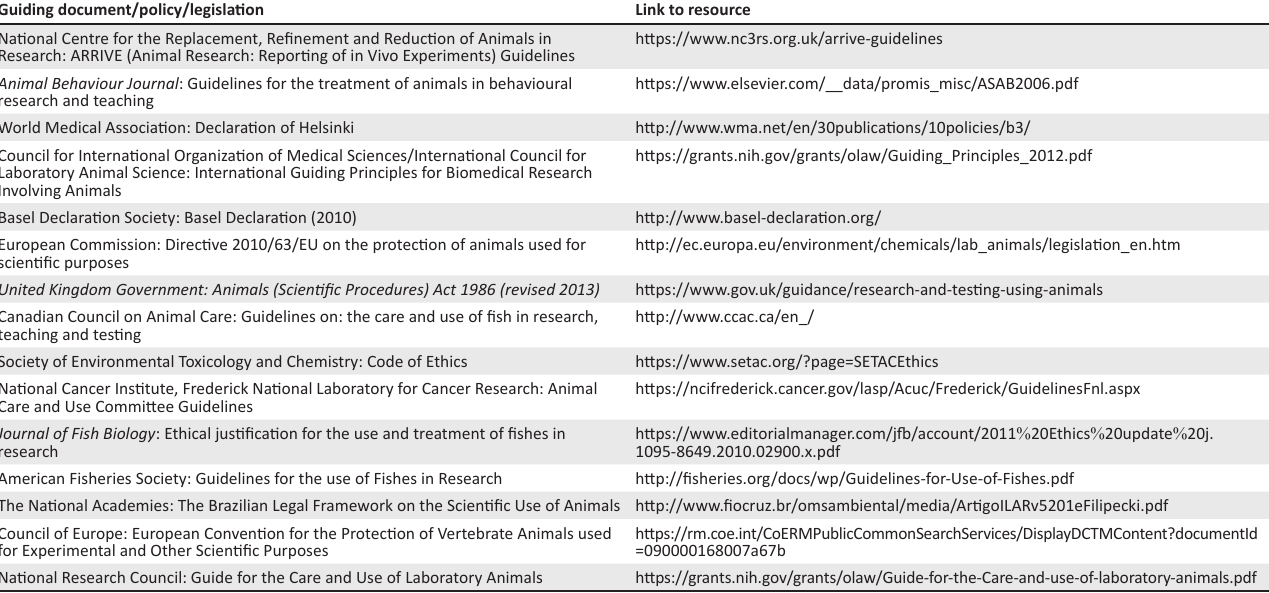
TABLE 1-A2: Web links to guiding documents, policies and legislation for the ethical treatment of animals in research, identified by 45 ISI-rated journals, in their instructions to authors. Guiding document/policy/legislation Link to